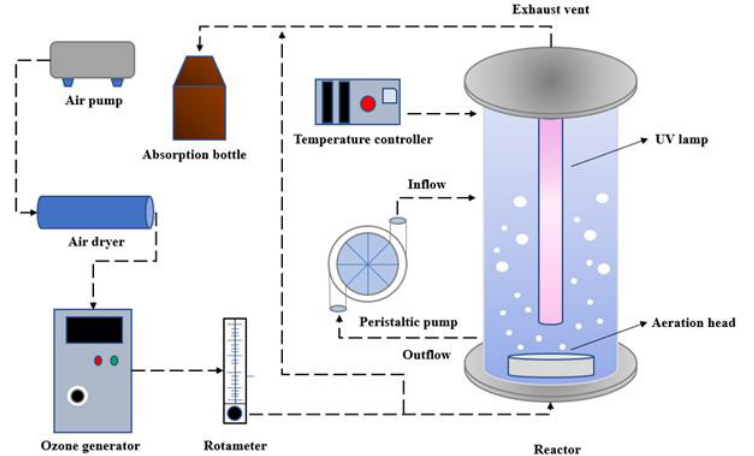
Figure 2. Experimental device diagram.